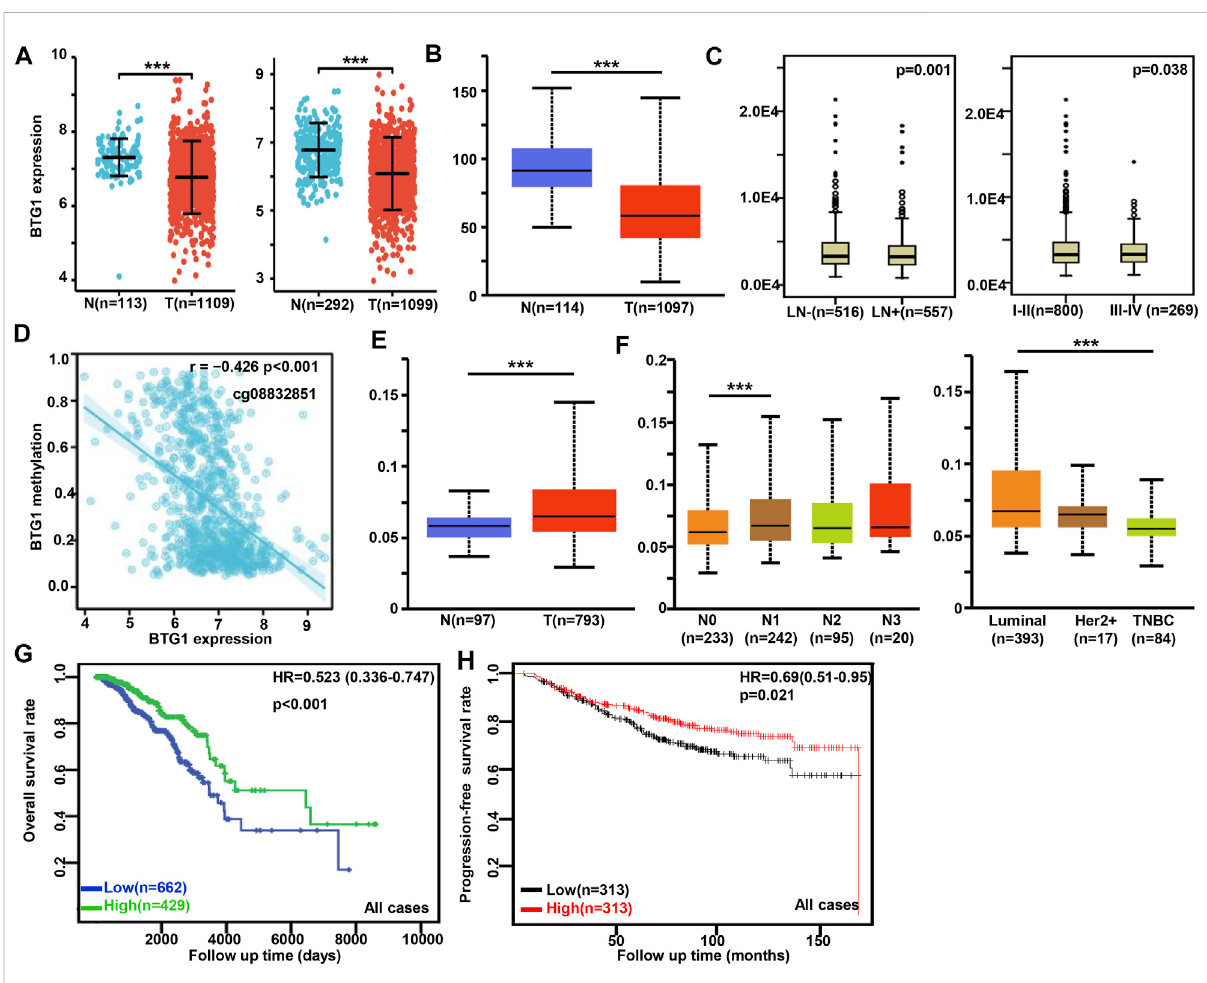
FIGURE 3 The clinicopathological and prognostic signi fi cances of BTG1 mRNA expression inbreast cancer. Xiantao (A) and UALCAN (B) dataset was used forbioinformaticsanalysistoexplore BTG1 expressioninbreastcancer. Alower BTG1 expressionwasdetectableinbreastcancerthanthat innormal mucosa ( p < 0.05). TCGA database showed that BTG1 was negatively correlated with lymph node metastasis (LN) and clinicopathological staging of breast cancer (C) p < 0.05. The negative relationship between BTG1 expression and methylation was analyzed in breast cancer using xiantao database (D) . Its methylation was higher in breast cancer than normal tissues in UALCAN (E) , and compared with N staging and molecular subtyping ofbreastcancer (F) . BTG1 expressionwaspositivelycorrelatedwithoverallsurvivalrateofthecancerpatientsbyTCGA (G) p <